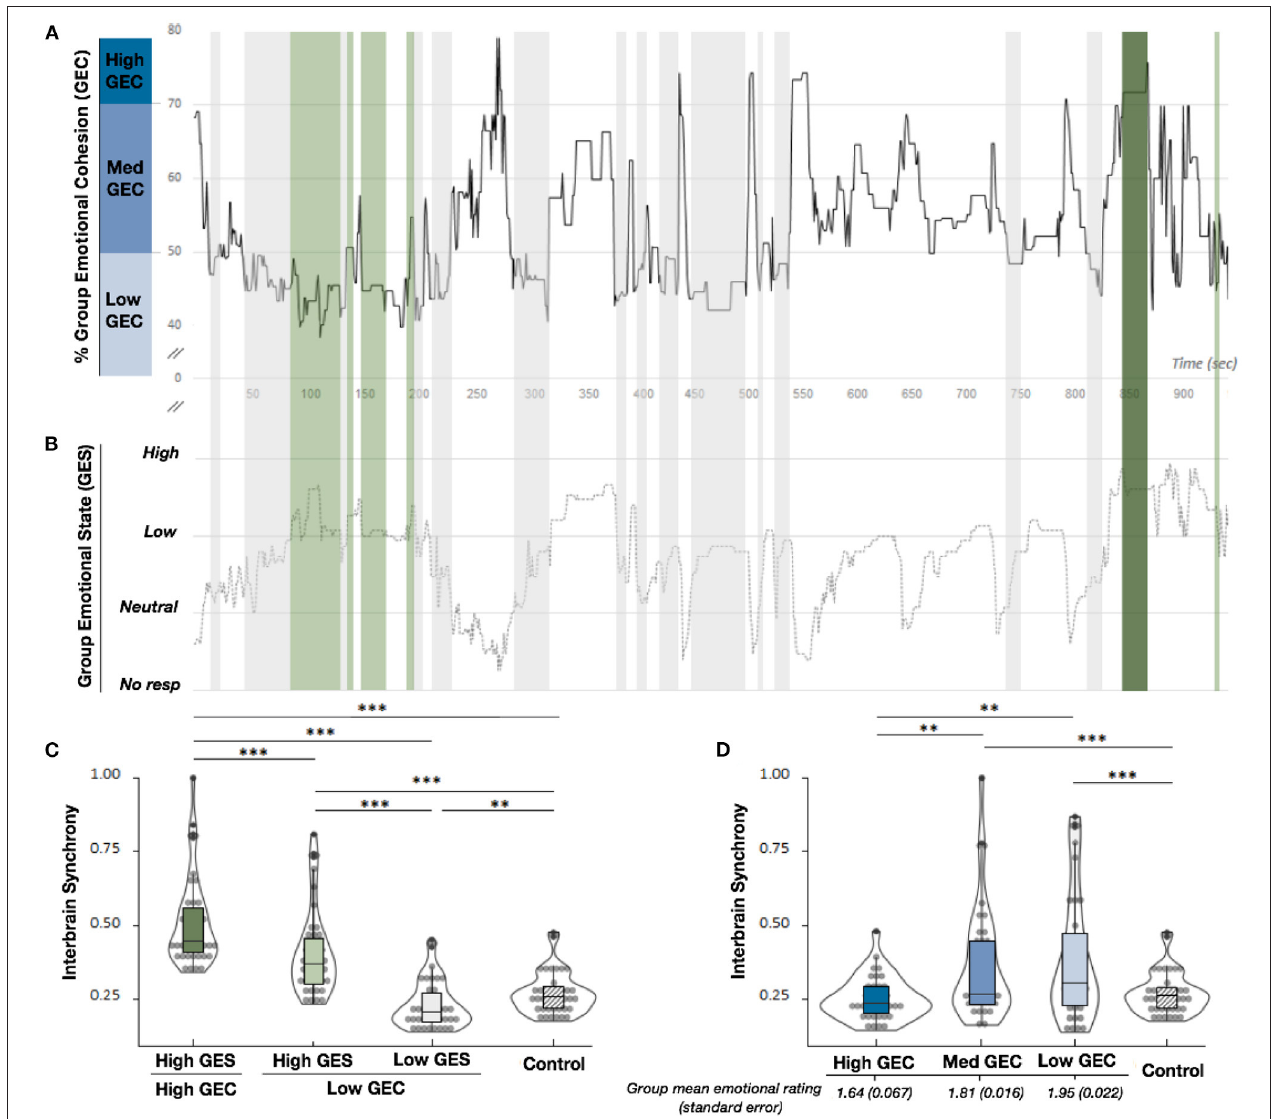
FIGURE 1 | (A) Representation of the averaged percentage of group emotional cohesion (GEC) ( n = 15 giving 105 pairs) derived from behavioral reports for one conductor performance calculated at a temporal precision to the nearest second. This is only a representation, analyses have been conducted with data collected throughout the concert. High GEC is in navy blue (A) , Med GEC is in cobalt blue (A) and Low GEC is in sky blue (A) . (B) Representation of the average of the group pleasure reports (n = 105 pairs) on smartphones according to four levels; Neutral, Low pleasure and High pleasure up to chills. Colors correspond to a specific moment visible on the schematic representation of both group emotional state and group emotional cohesion; High GEC/High GES in dark green, Low GEC/High GES in light green, and Low GEC/Low GES in light gray. (C) Box plot of the theta coherence estimation calculated during High vs. Low group emotional cohesion for high group emotional state or low group emotional state related to music [see (A,B) , green/gray]. (D) Box plot of the theta coherence estimation calculated when the group had a High GEC [navy blue (A) ], a moderate GEC [cobalt blue (A) ], or a low GEC [sky blue (A) ]. For both plots: ** p < 0.01, and *** p <